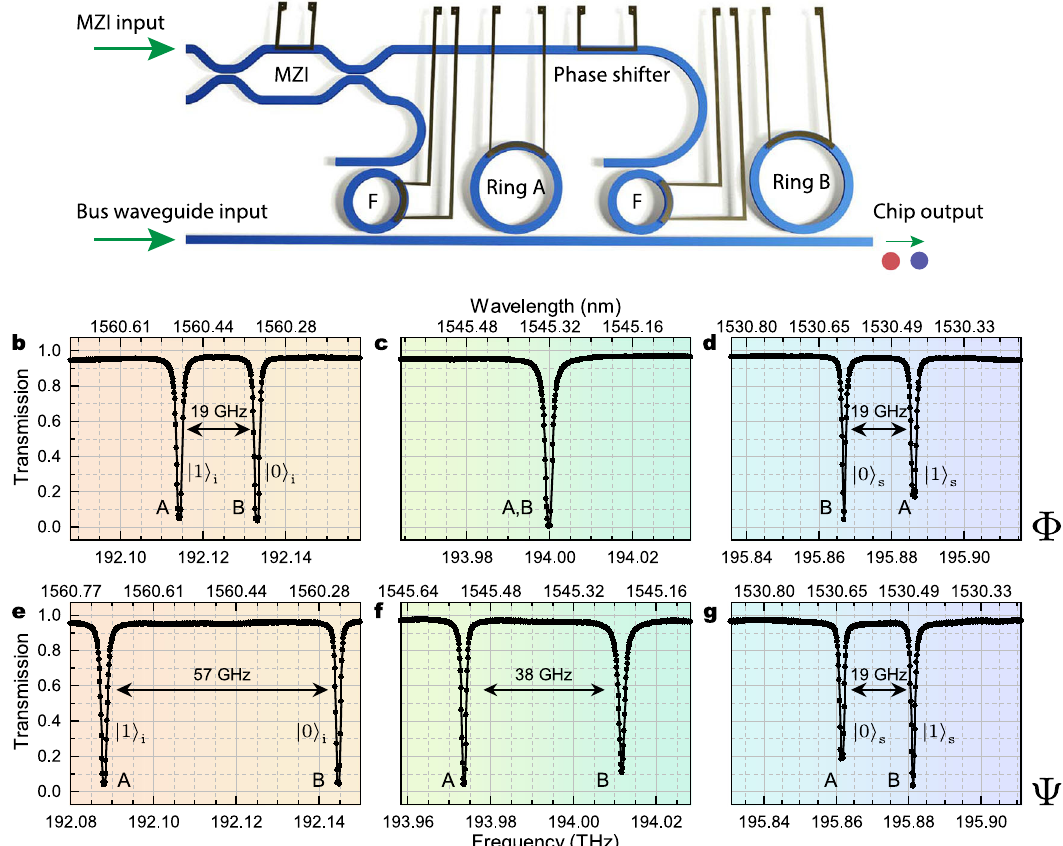
Fig. 1 | Device layout and transmission spectra. a Schematic of the device, in which a Mach Zehnder Interferometer (MZI) is used to route optical pumping power to the two generating rings (Ring A and Ring B) via two add-drop fi lters (F). The pump relative phase for the two rings iscontrolled by a thermo-electric phase shifter. b – d Linearcharacterizationofthesamplethroughthebuswaveguide,with the device operated in con fi guration Φ . A detail of the transmission spectrum around the idler (panel b , m = − 5), pump (panel c , m =0), and signal (panel